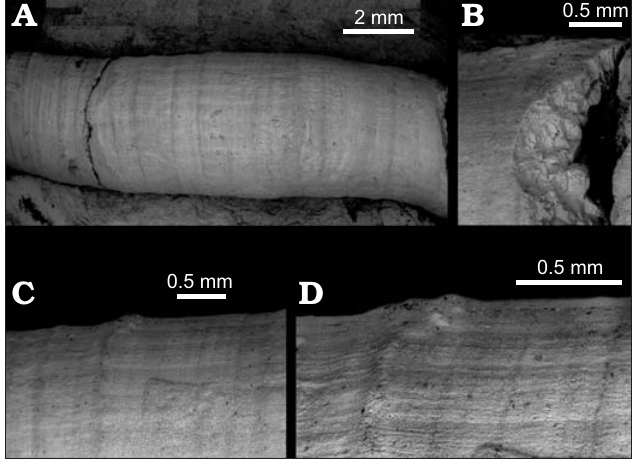
Fig. 4. Serpulid polychaete “ Serpula ” prisca sp. nov. (holotype PMC. S5.15.09.2017) from the Wordian to upper Permian, “Pietra di Salomone” Lime stone, Sicily, Italy. A . Central portion of the tube glued together, with only feeble growth lines on its outer surface. B . Tube wall with large second- ary calcite crystals pointing to complete recrystallization. C . Close-up of outer surface showing very thin and smooth growth lines. D . Magnification of C, with closely spaced, relatively prominent growth lines, crossed by nearly imperceptible longitudinal striations. All SEM